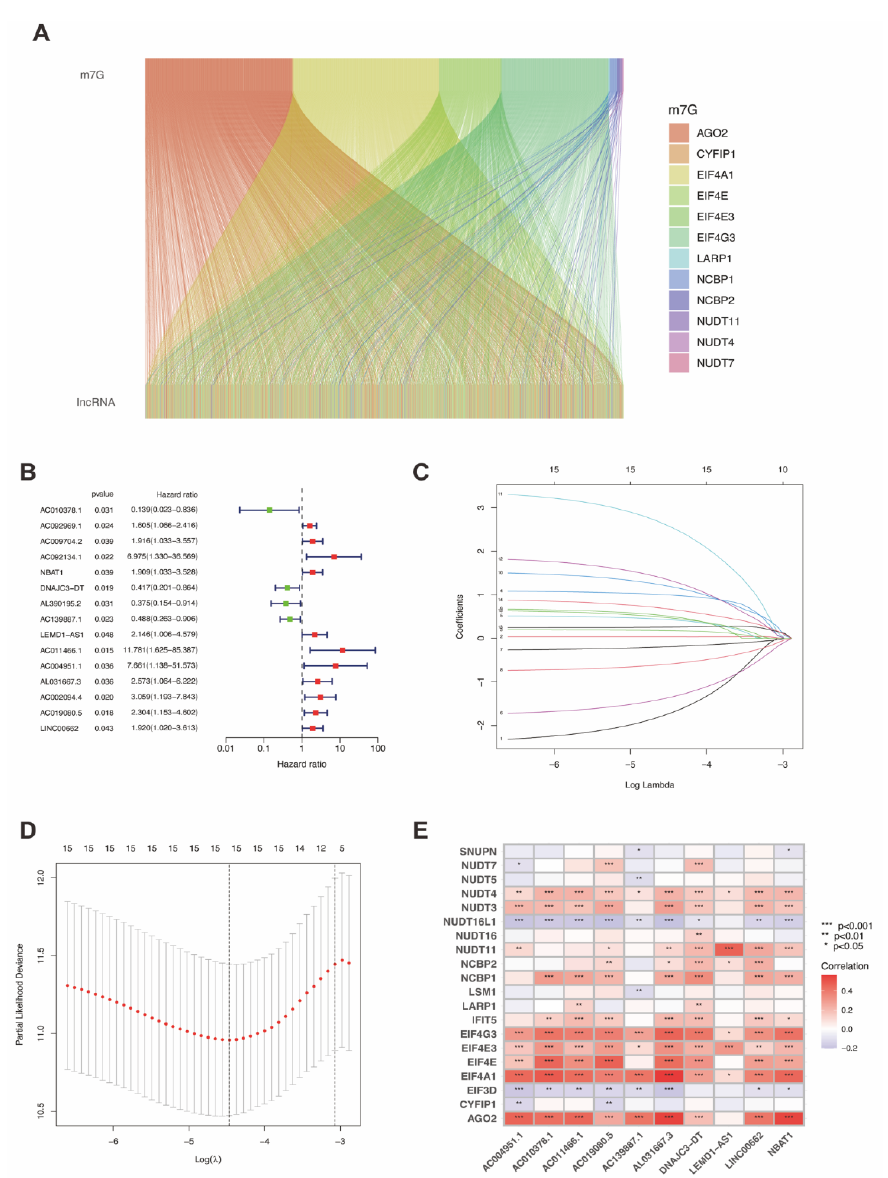
Figure 2. Identification of prognostic m7G-related lncRNAs. ( A ) Sankey diagram of the correlation between MRGs and lncRNAs. ( B ) Univariate Cox regression analysis identified 10 MRLs correlated with prognosis. ( C , D ) Cvfit and lambda curves of Lasso regression analysis. ( E ) The correlation between 19 MRGs and 6 MRLs identified by multivariate Cox